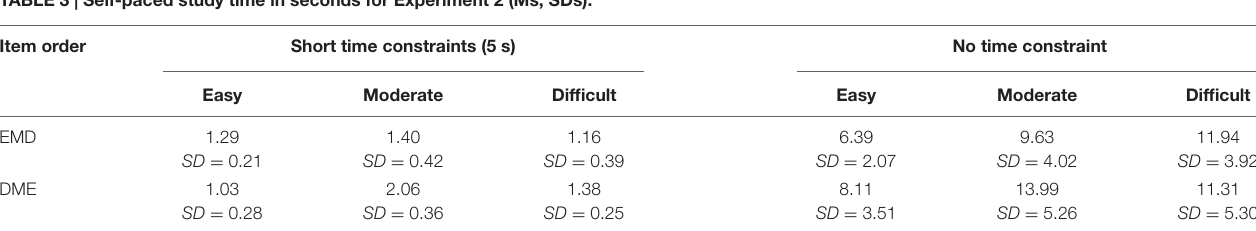
TABLE 3 | Self-paced study time in seconds for Experiment 2 (Ms,